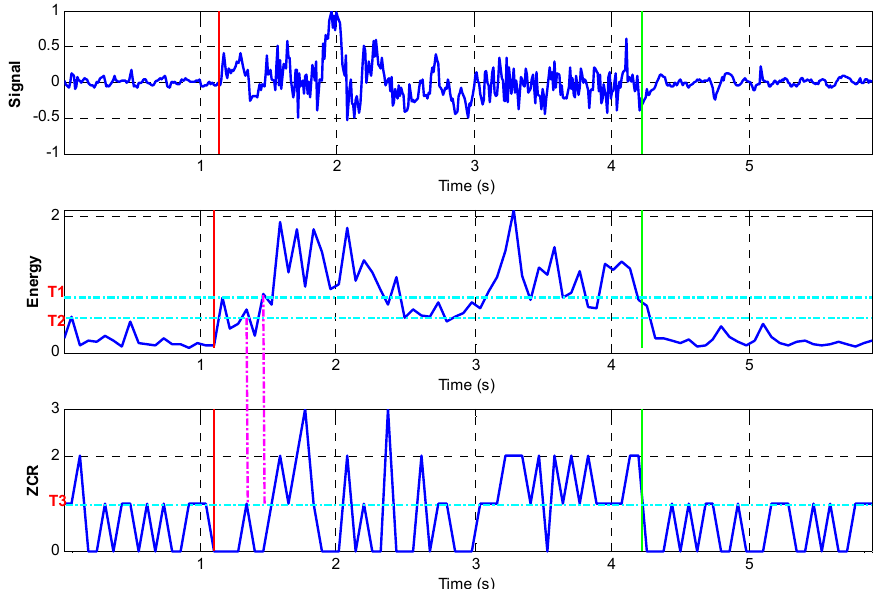
Figure 6. Double threshold method for zero interval detection.